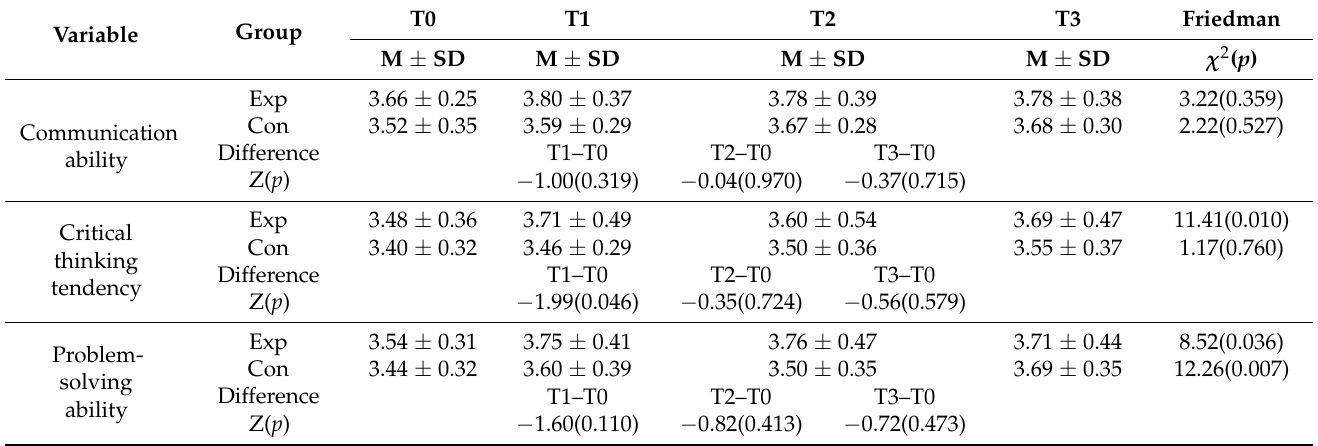
Table 3. Summary of the test results for intergroup